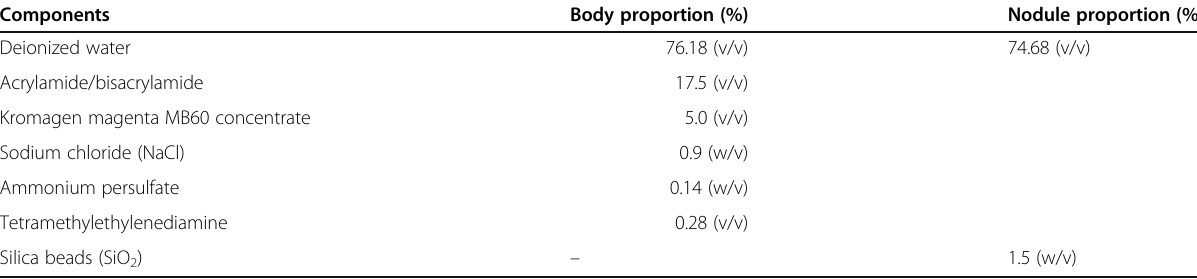
Table 1 Ingredients for the body and nodule based on the work of Negussie et al. [21, 22]